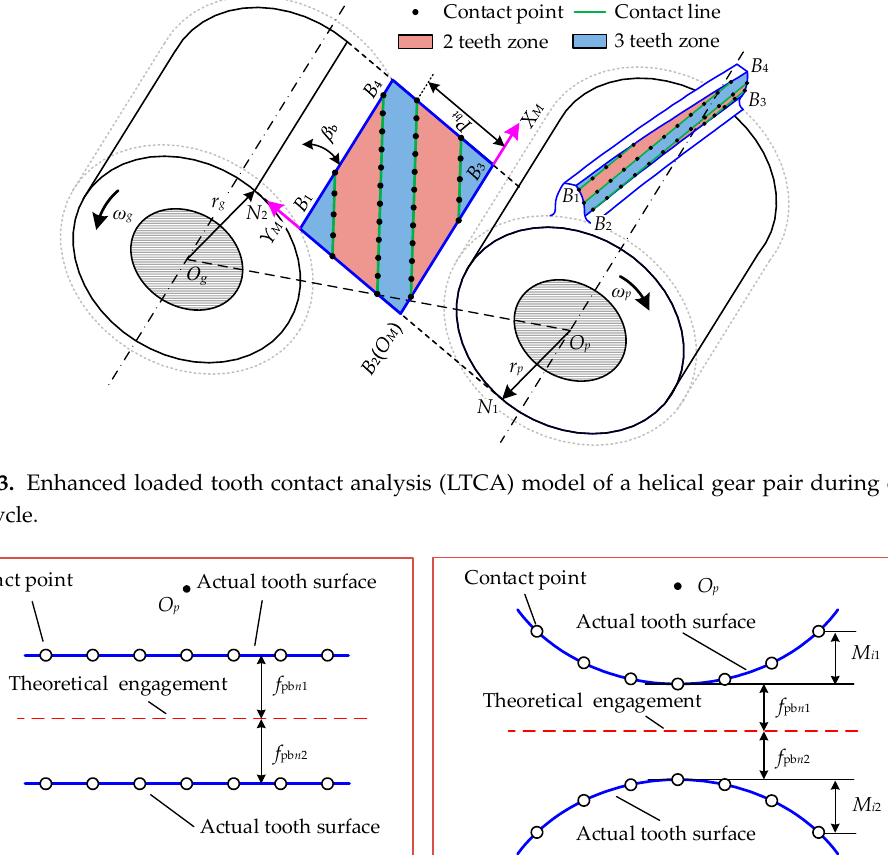
P bt Figure 2. End-side view and mating state of helical gear pair with cumulative pitch deviations. 2.1.2. Determination of LPMS, STE, and CMS In our previous work, a basic LTCA model with high computational efficiency has been developed [26]. It can be used to calculate the short period mesh stiffness and transmission error of a cylindrical gear pair with short period tooth flank errors. In this section, considering the difference of tooth engagement process in different mesh cycles and the actual engagement condition of each tooth pair, the basic LTCA model is extended to an enhanced LTCA model, which can be applied to the calculation of long period mesh excitations. Figure 3 shows the enhanced LTCA model for a helical gear pair during one mesh cycle, and gives the arrangement of potential contact lines and contact points on plane of action (POA) B 1 B 2 B 3 B 4 . For a helical gear pair with total contact ratio of 2 to 3, it can be divided into 2 teeth and 3 teeth zone. r p and r g are the radius of base circle of driving and driven gear. O p and O g are the rotational center of the two gears. β b is helix angle of gear base circle. The rotational speeds of the two gears are denoted